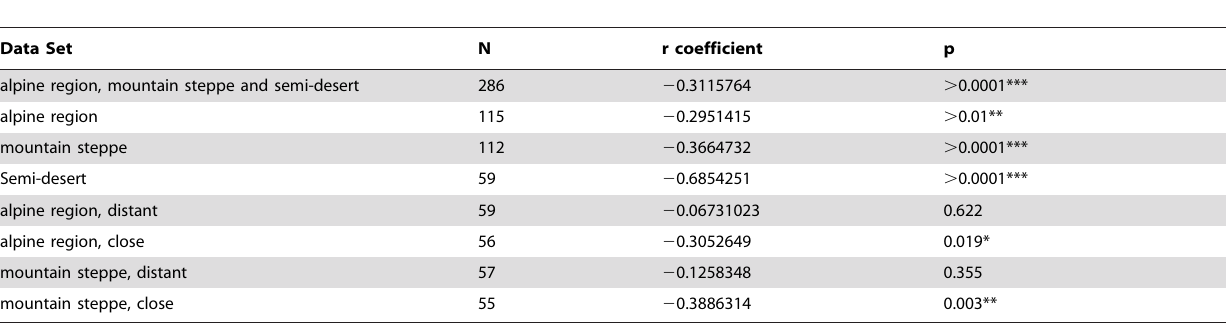
Table 4. Pearson’s correlation analysis between food quality (measured as the ratio of nitrogen/ADF) and DOM for pooled data, single pooled ecotypes and each distance class per